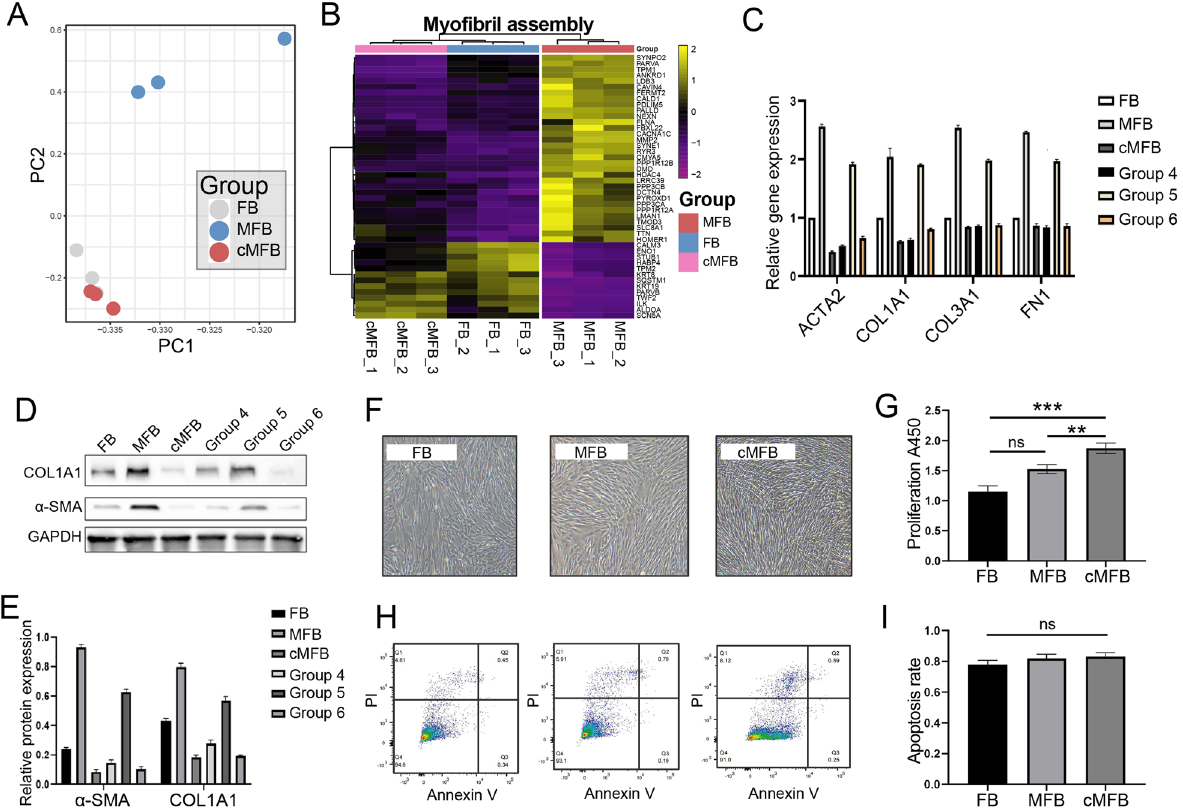
Fig. 5 Identification of the cellular properties and reversibility of uMSC-mediated MFB de-differentiation. A Principal component analysis (PCA) on transcriptomes of FB, MFB, and co-cultured MFB samples. B Unsupervised clustering heatmap of 45 gene-panel involved in myofibril assembly on FB, MFB, and co-cultured MFB samples. C RT-qPCR assays on the expression of ACTA2 (encoding for a-SMA), COL1A1 , COL3A1, and FN1 in cells from the 6 group settings: (1) Untreated FB; (2) MFB; (3) Short-term co-cultured MFB (FB-like cells); (4) Long-term co-cultured MFB; (5) FB-like cells treated with TGF-β1 without uMSC feeder layer; (6) TGF-β1-treated FB-like cells with additional uMSC feeder layer. D , E Western blot assays on FN1, COL1A1, and a-SMA proteins in cells from the 6 group settings: (1) Untreated FB; (2) MFB; (3) Short-term co-cultured MFB (FB-like cells); (4) Long-term co-cultured MFB; (5) FB-like cells treated with TGF-β1 without uMSC feeder layer; (6) TGF-β1-treated FB-like cells with additional uMSC feeder layer. F , G The proliferation of FB, MFB, and co-cultured MFB by light microscopy and CCK-8 assays. H , I Apoptosis FB, MFB and co-cultured MFB by Annexin V/PI assays. * < 0.05; **P < 0.01; ***P <